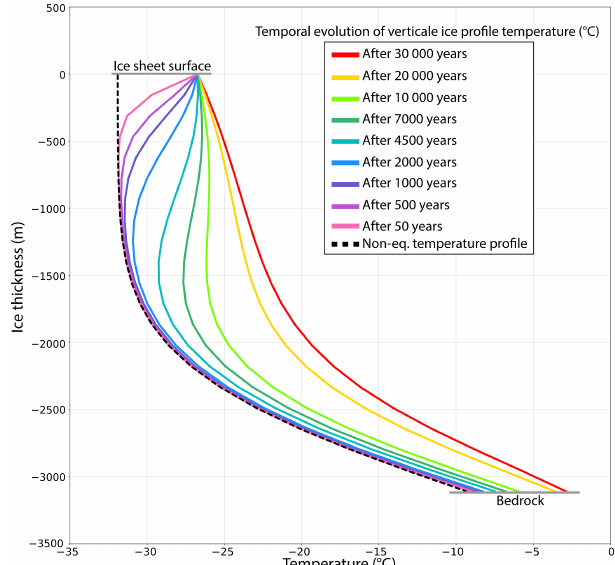
Figure 12. Vertical temperature profiles ( ◦ C) from the ice sheet surface to the bedrock over the central region of Greenland (73– 74.5 ◦ N, 40–43 ◦ W). The black dashed line is the non-equilibrated temperature profile used in Edwards et al. (2014). The coloured lines are the profiles over the course of the long 30kyr experiment for the temperature calculation. The red profile is the one used as the initial condition for the experiments shown in Sect.